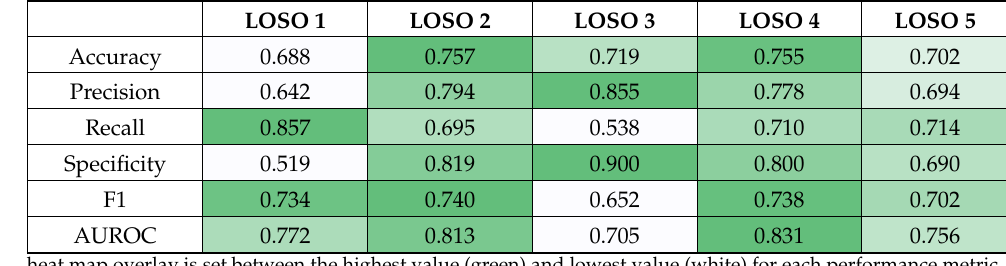
Table 1. Effect of leave one subject out (LOSO) holdouts on ShrapML testing performance. Results are shown as average results for n = 3 replicate trained models. Heat map overlay is set between the minimum and maximum value for each performance